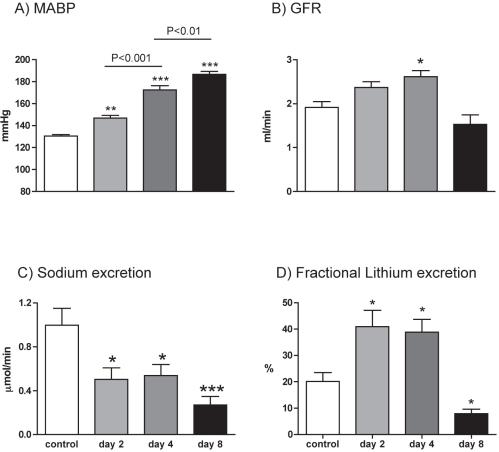
Renal function in anaethetized rats.A) mean arterial blood pressure (MABP); B) glomerular filtration rate (GFR); C) urinary sodium excretion and D) the fractional excretion of lithium. Measurements were made in cyp1a1-Ren2 transgenic rats, on either day 2 (n = 9), 4 (n = 9) or 8 (n = 9) in the induction regimen. Non-induced rats (n = 8) served as control. Data are mean ± SE. Statistical comparisons were made using ANOVA with Bonferroni post-test. ***P<0.001, **P<0.01, *P<0.05 versus the control group.